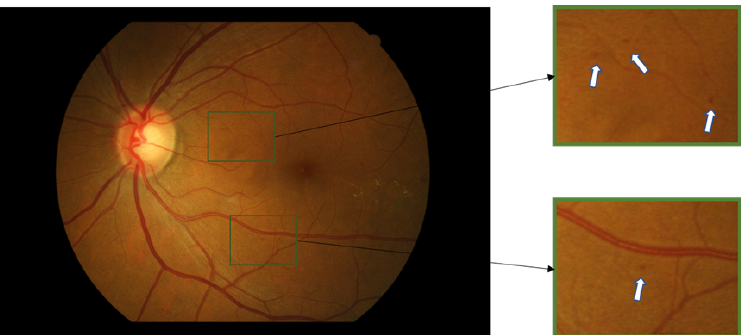
Figure 1. An example of a color fundus image with MAs. The areas with MAs are identified with a green box and zoomed in on the right side of the image, the dark blobs that the white arrow points to are